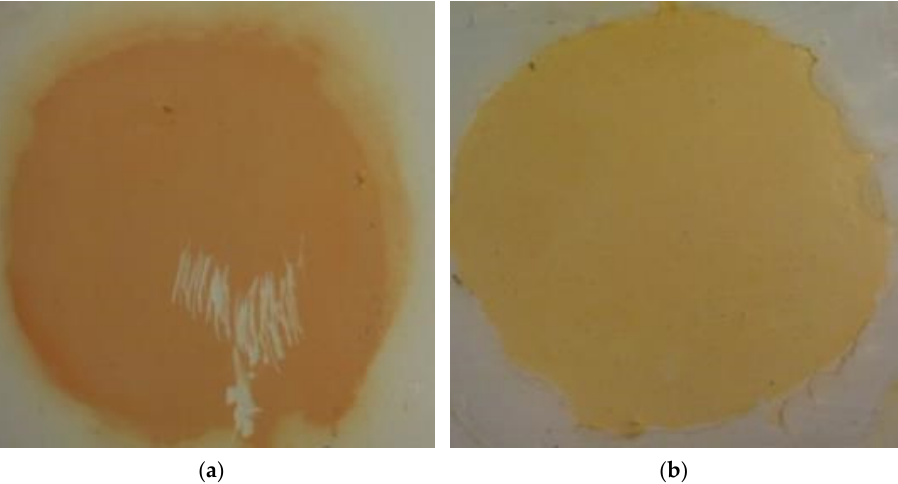
Figure 10. The NBR-CW coating: ( a ) colour change after 90-day exposure to 30% HCl; ( b ) colour change after exposure to 5% CH 2 O 2 for 120 days.